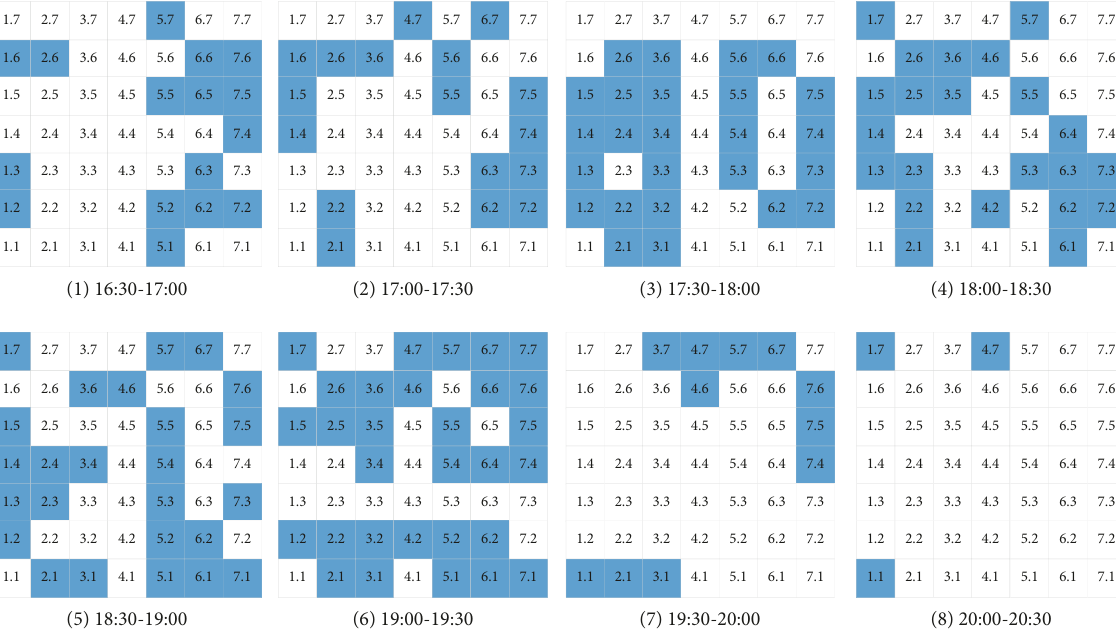
Figure 16: Evolution of congestion in evening rush